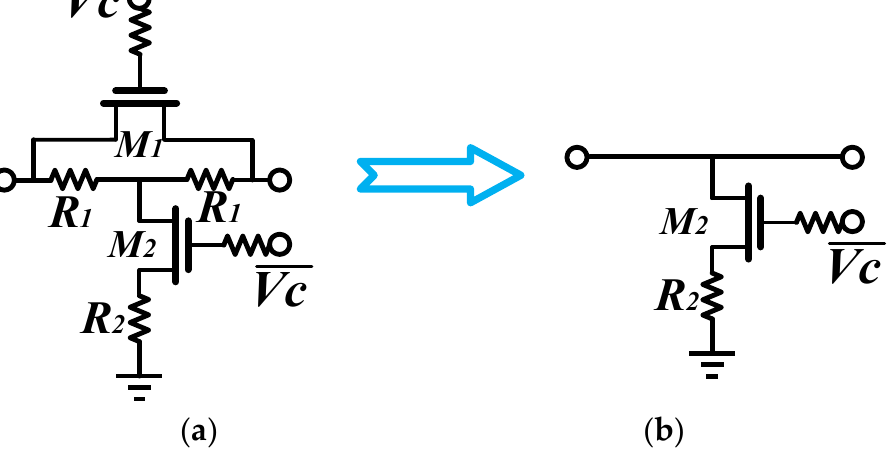
Figure 3. The relative attenuation of the conventional T-type attenuation cell. The IL of the conventional T-type attenuation cell is related to the resistance of the series transistor in the on-state. Though increasing the gate width of the transistor can reduce the unavoidable series resistance, the large coupling capacitance generated at the same time severely degrades the phase stability of the T-type attenuation cell. Fortunately, the same function can be achieved by removing the series transistor when using the T-type structure for small attenuation cells, as shown in Figure 4. Removing the series transistor not only reduces the IL of the T-type cell but also reduces the parasitic effect, allowing the attenuation cell to achieve a wider bandwidth. As shown in Figure 5, the simplified T-type attenuation cell exhibits accurate attenuation and stable amplitude variation.